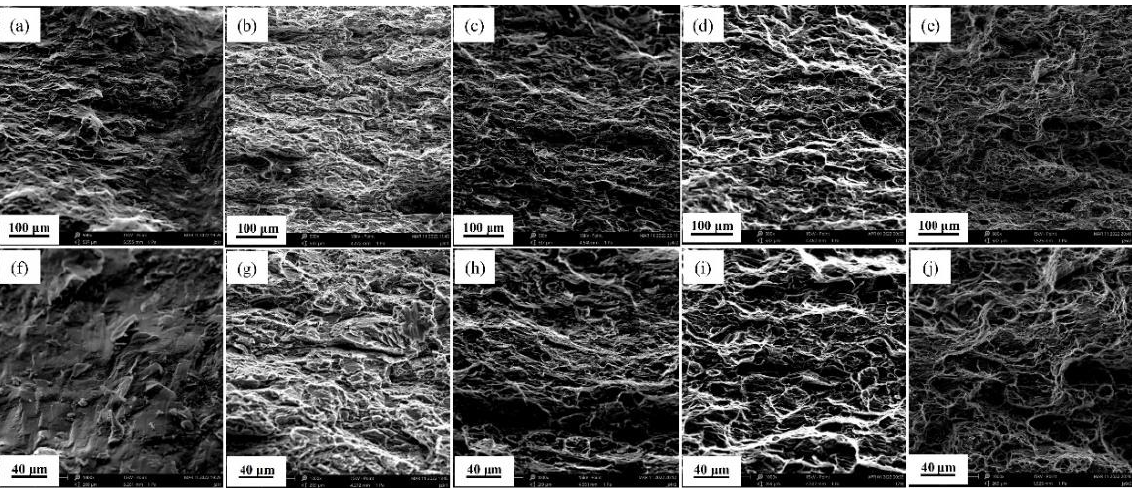
Figure 8. Tensile fracture images of the rolled sheets with different Y contents: ( a , f ) AZY0; ( b , g ) AZY1; ( c , h ) AZY2; ( d , i ) AZY3; and ( e , j ) AZY4.